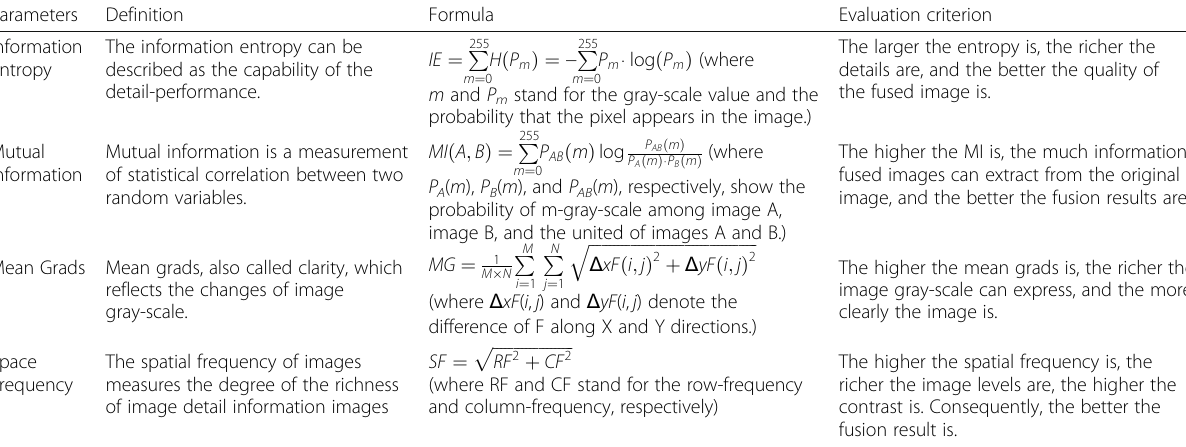
table Table 2: (a)Analysis from the information entropy parameters The information entropy reflects the integration of the detail expression of the image after fusion. The information entropy of wavelet-weighted fusion, α channel fusion, and pseudo-color fusion concen- trates between 4.5 and 6. Moreover, the result of wavelet-weighted fusion is better than α channel fu- them are better than basic pseudo-color fusion, Table 3 Main characters of the evaluation parameters Parameters Evaluation